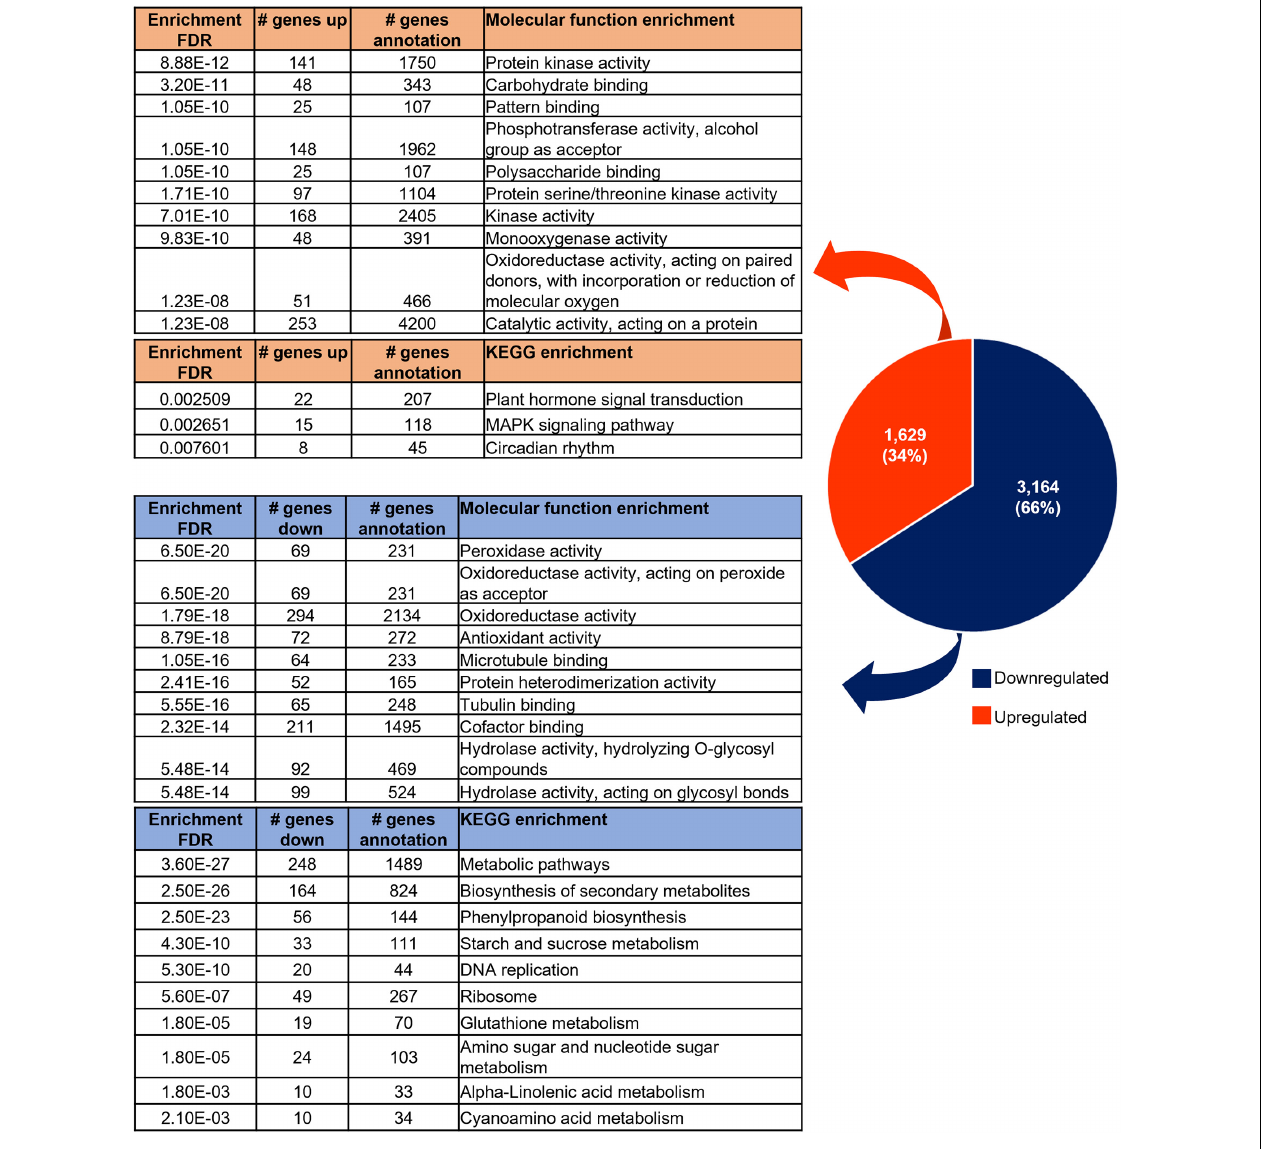
10 downregulated genes had function associated with “early nodulin-related” or “early nodulin-like